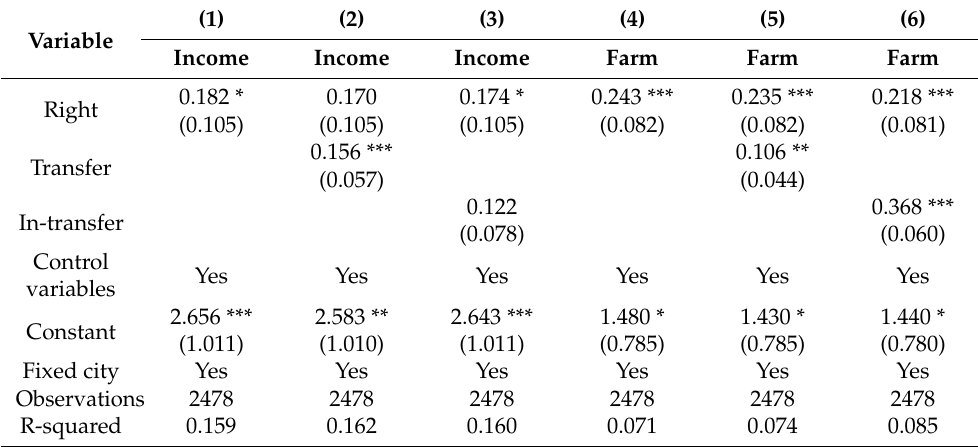
Table 8. Mechanism regression results of rural land right on farmers’